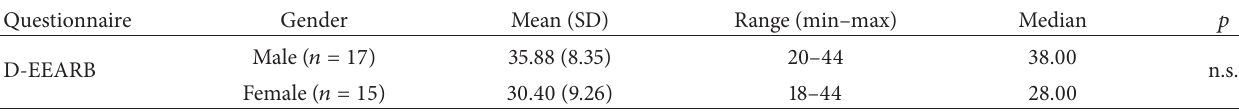
Table 3: Psychosocial results by